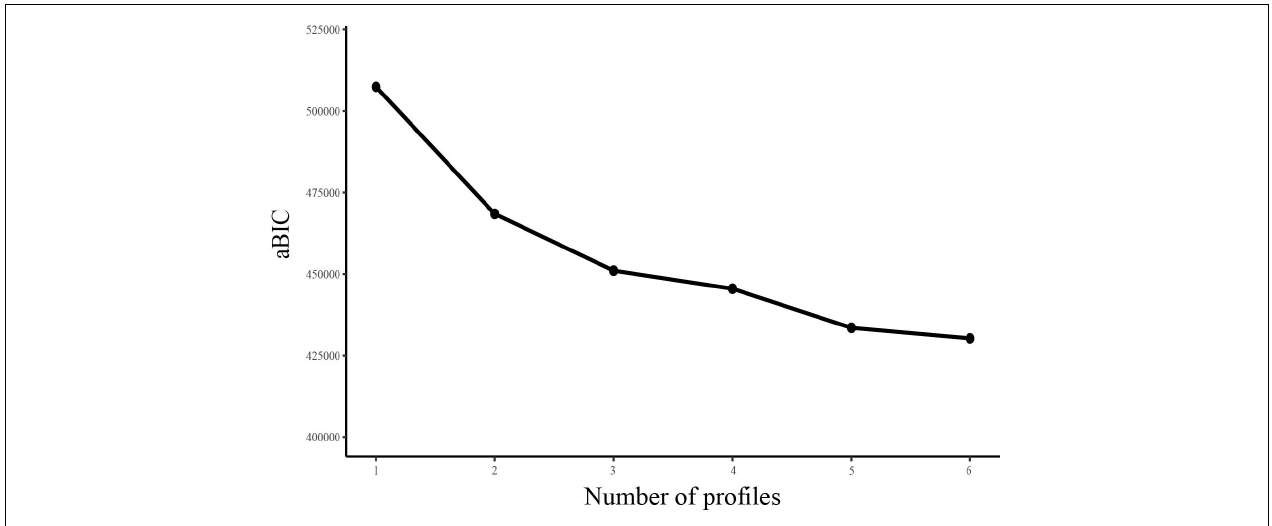
FIGURE 2 | Three profiles of the best-fitting three-class pattern based on CES-D-10 items. CES-D-10, 10-item Center for Epidemiologic Studies Depression Scale.